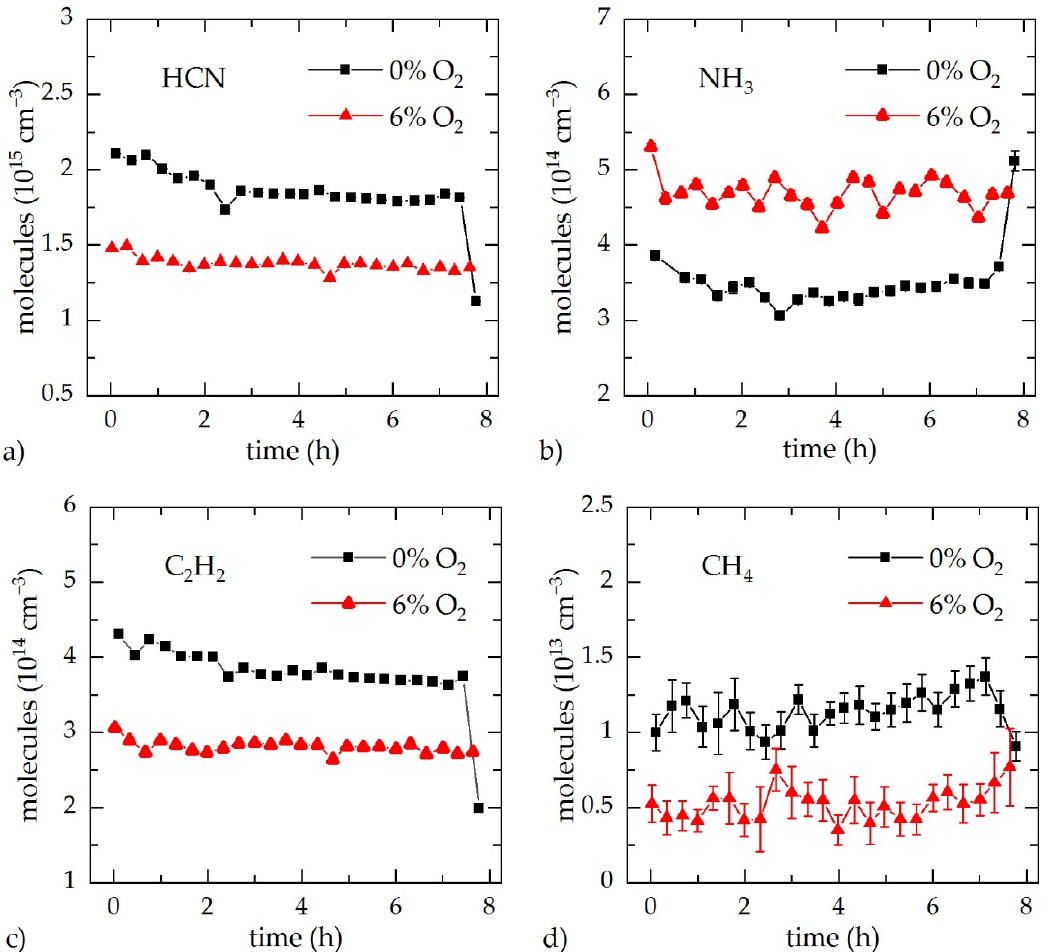
Figure 3. Monitored concentrations of ( a ) HCN, ( b ) NH 3 , ( c ) C 2 H 2 , and ( d ) CH 4 during the treatment in the industrial scale ASPN reactor with (red) and without (black) the admixture of 6% O 2 in the N 2 -H 2 feed gas. T = 540 °C, N 2 + O 2 = 90%, H 2 = 10%, P AS = 6.0 kW.